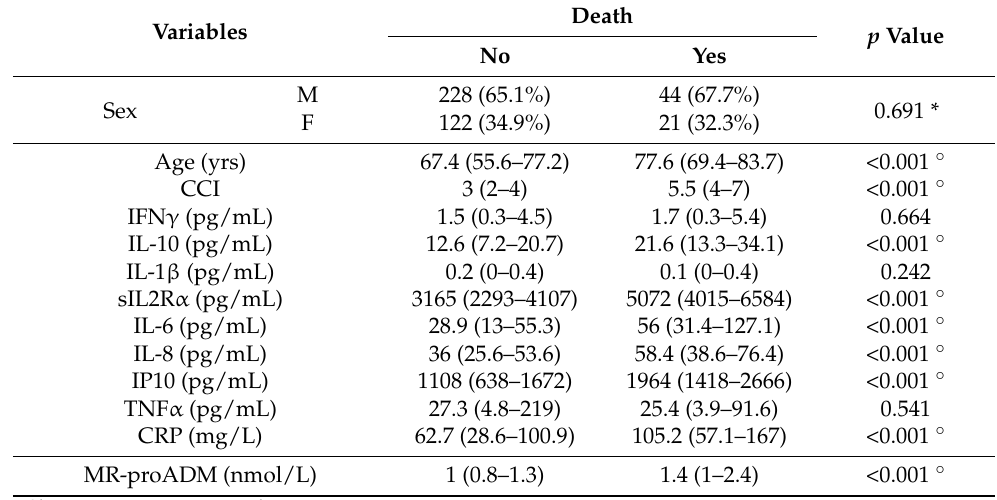
Table 4. Demographics, clinical and laboratory markers in deceased and non-deceased patients.